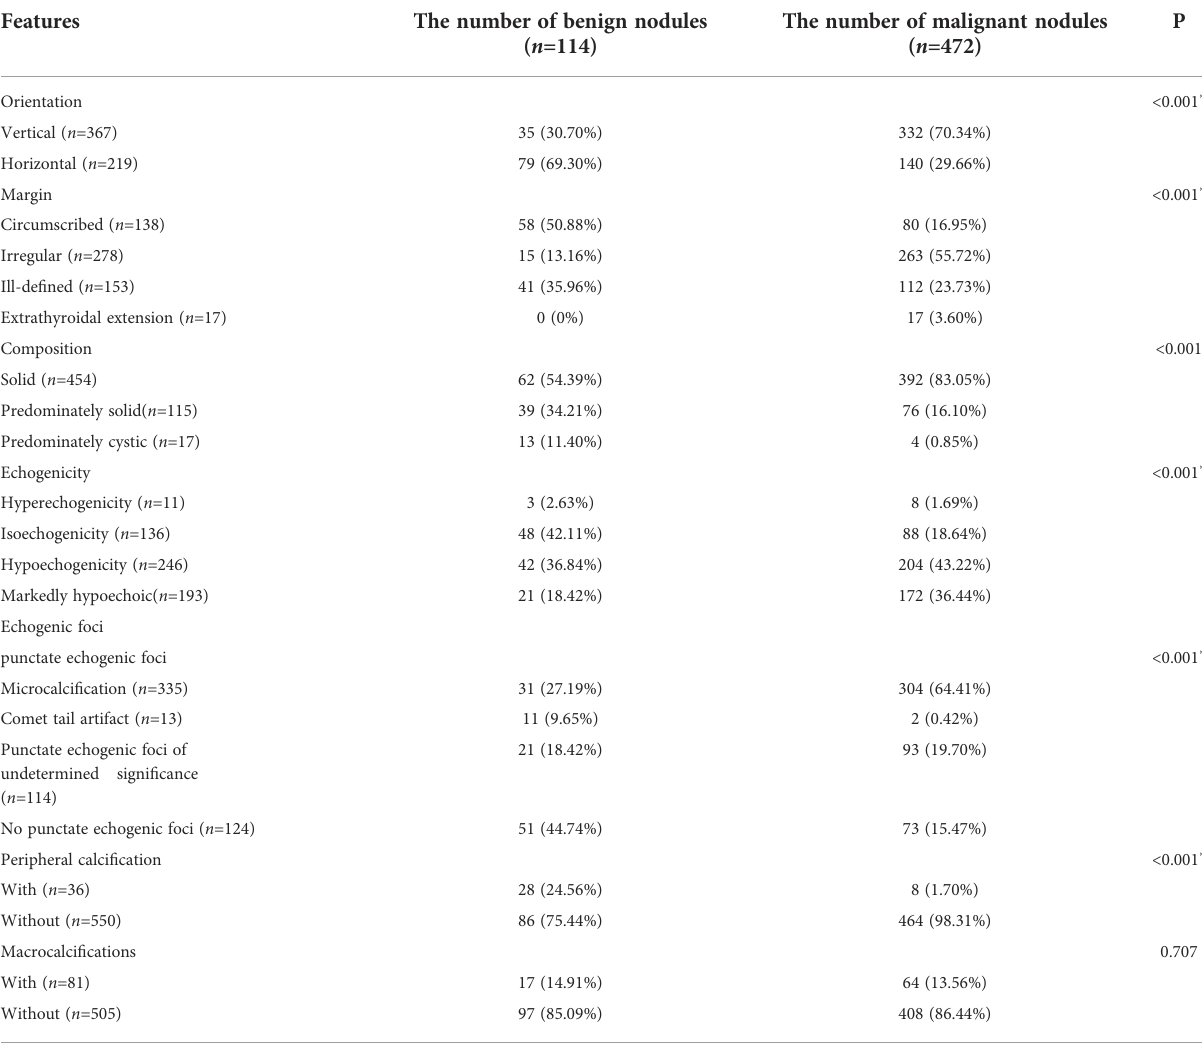
TABLE 2 Conventional ultrasound features of benign and malignant nodules.